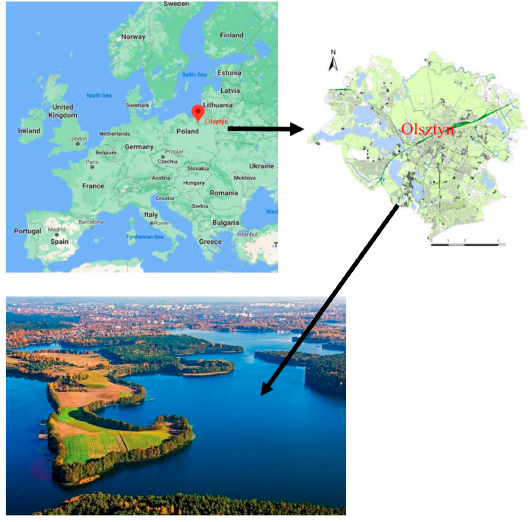
Figure 2. Location of the city of Olsztyn. Source: own